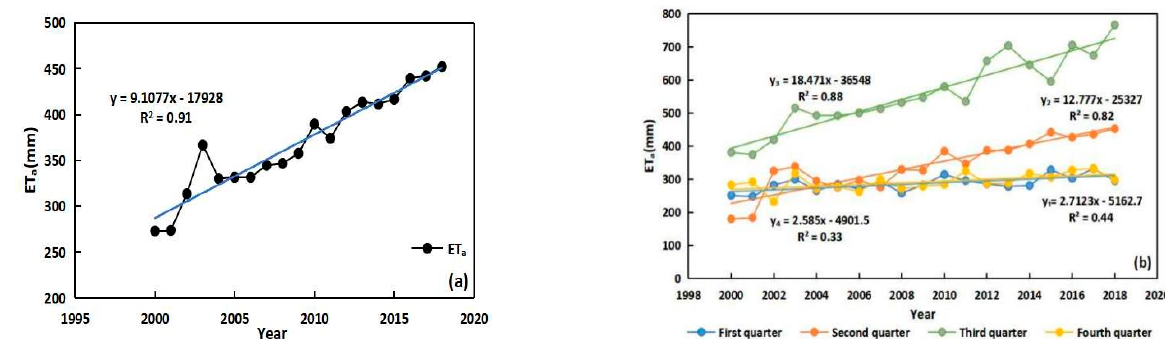
Figure 6. Spatial average trends of ( a ) annual ETa and ( b ) quarterly ETa scales during 2000–2018. Spatially, during 2000–2018, the NDVI showed the trend of increase in most areas in the LP (93.3%) and presented a significant increasing trend in the 78.4% area of the LP (Figure 7a). The ET a showed the trend of increasing in most areas of the LP (99.4%) and presented a significant increasing trend in the 97.7% area of the LP (Figure 7b). Obviously, the spatial trends of annual ET a were consistent with that of the NDVI, which increased from northwest to southeast. On the contrary, as shown in Figure 7c, ET p in the LP showed a decreasing trend ( − 4.9 mm yr − 1 ) and was found to have an obvious complementary relationship with ET a in the spatial trend pattern by comparing the spatial pattern of ET a trends.